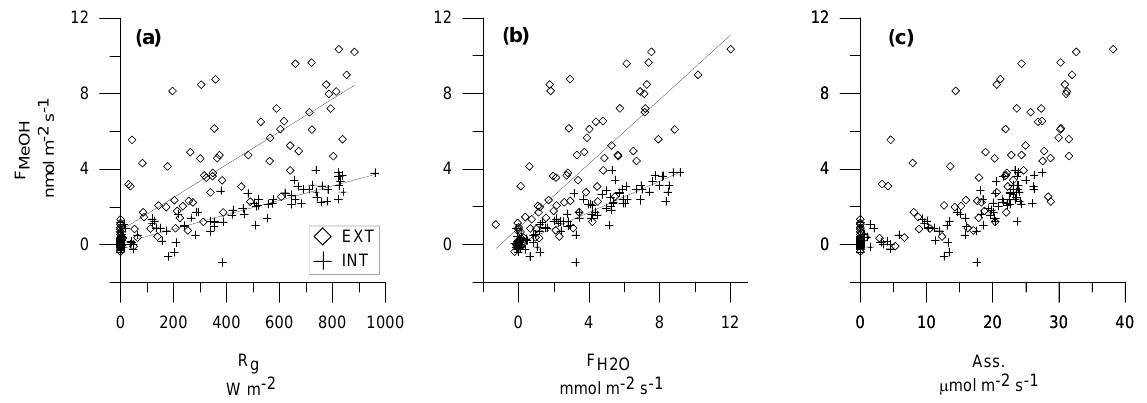
) , and (c) assimilation (Ass.) for the 2 O